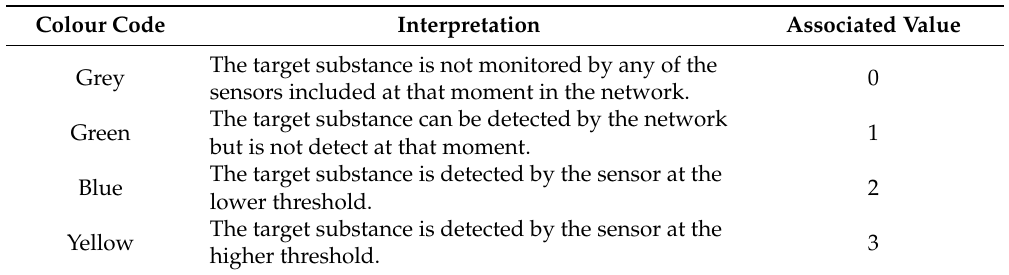
Table 4. Interpretation of the colour code used for the output of the expert system after the Step 1. Colour Code Interpretation Associated Value